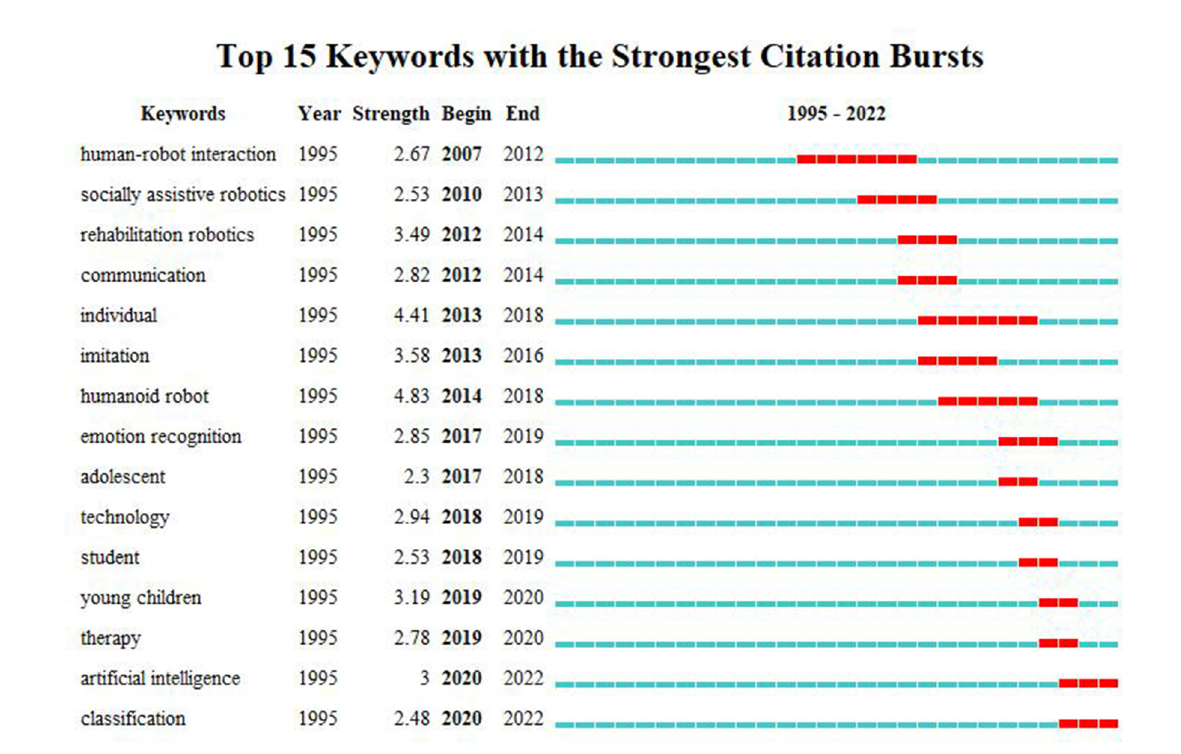
FIGURE12 The top 15 keywords with the strongest citation bursts related to Al on